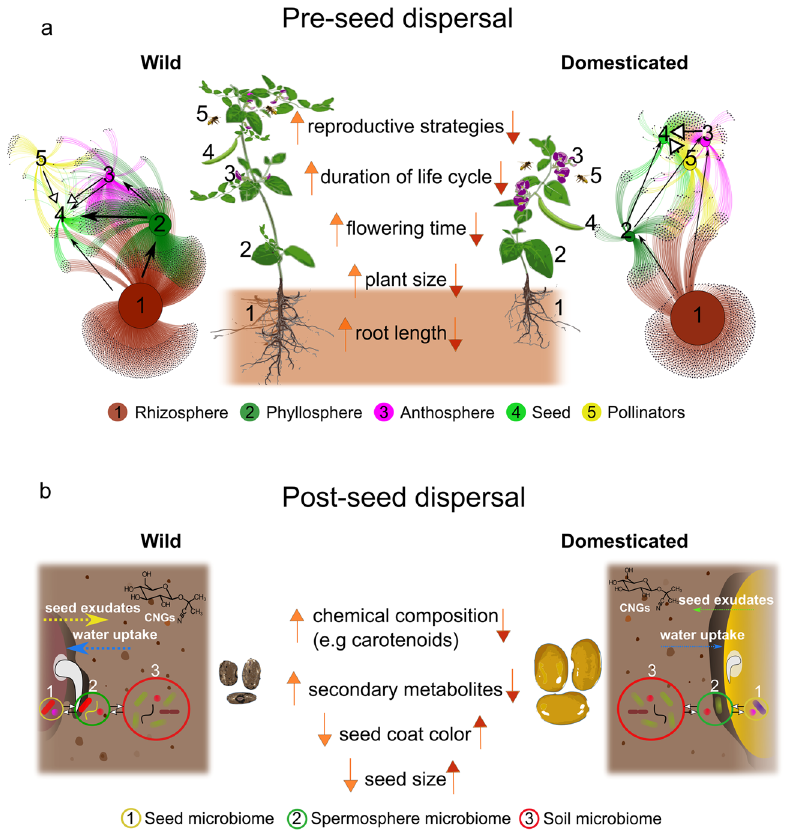
Fig. 2 Phenotypic changes introduced with plant domestication have consequences for the microbial connectivity between different plant compartments and the spatial and temporal dynamics of plant – microbe interactions in the spermosphere. a Pre-seed dispersal: Phenotypic changes caused by plant domestication affect both the below and above-ground plant compartments. In wild plants, we propose that the microbial connectivity (sharing of microbial members) between the environment and plant compartments, visualised as a bipartite microbial network, could re fl ect a higher degree of vertical transmission of microorganisms to plant seeds (represented by wider black arrows), under the in fl uence of host-microbiome control mechanisms. Vertical transmission can occur from the rhizosphere (1) to the seed compartment (4); from the rhizosphere (1) and phyllosphere (2) to the seed compartment (4); or from the rhizosphere (1), phyllosphere (2) and anthosphere (3) to the seed compartment (4). Horizontal transmission (white arrow) can occur from plant to plant in the rhizosphere and phyllosphere via air-borne, soil-borne and water-borne inocula, vectors, and mechanical transmission (not illustrated), from pollinators (5) to the seed compartment (4) or from the anthosphere (3) to the seed compartment (4). We speculate that domesticated plants exhibit differences in microbial connectivity compared to their wild counterparts. In this example, we predict higher importance of horizontal transmission (represented by wider white arrows) in the seed microbiome assembly. b Post-seed dispersal: Phenotypic changes caused by plant domestication can affect the spatial and temporal dynamics of plant – microbe interactions in the spermosphere. Wild plants have smaller seed sizes and different colours of the seed testa compared to domesticated plants. Water uptake may be negatively correlated with seed or seed pore size and seed colour is linked to morphological features of the seed testa in fl uencing imbibition rate. The dynamics of seed germination, imbibition and seed exudation differ from domesticated plants. Secondary metabolites such as cyanogenic glycosides (CNGs) and antimicrobial proteins may also be more abundant or present at higher concentrations in seeds of wild plants. We speculate that these phenotypic changes are likely to lead to different spatial and temporal dynamics of interactions between the seed microbiome (1), the spermosphere microbiome (2), and the soil microbiome (3). In the example shown, seeds of domesticated plants germinate slowly, resulting in a different spermosphere microbial community compared to wild plant seeds. This situation could be reversed for seeds of wild plants that manifest dormancy. In this case, seeds of domesticated plants would germinate faster, regardless of seed